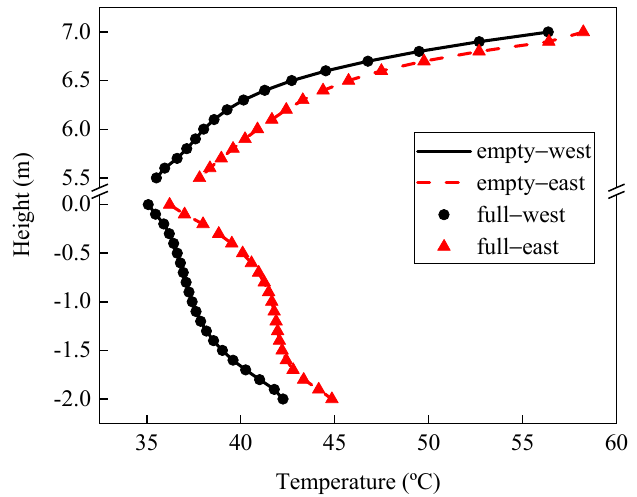
Figure 13. Vertical temperature gradients of the surfaces B and C in summer. Cubic polynomials are used to get the fitted curve of temperature gradient in Figure 14.